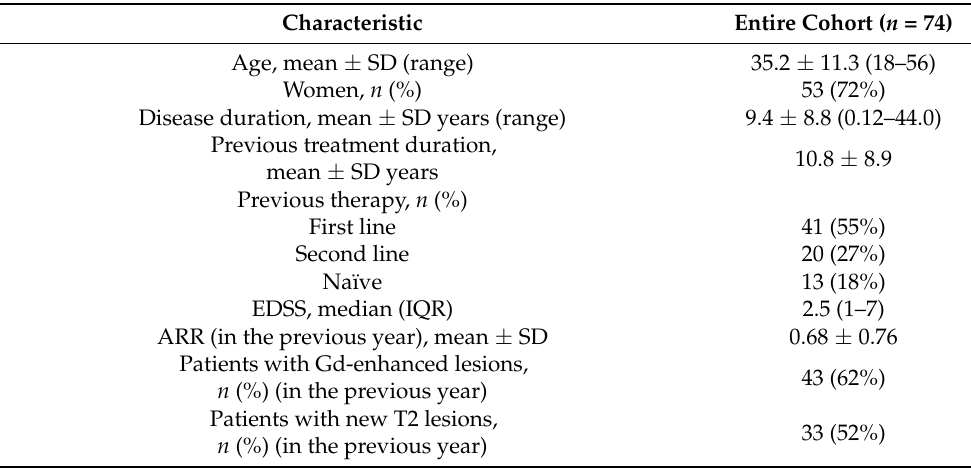
Table 1. Demographic and baseline clinical characteristics of the multiple sclerosis patient